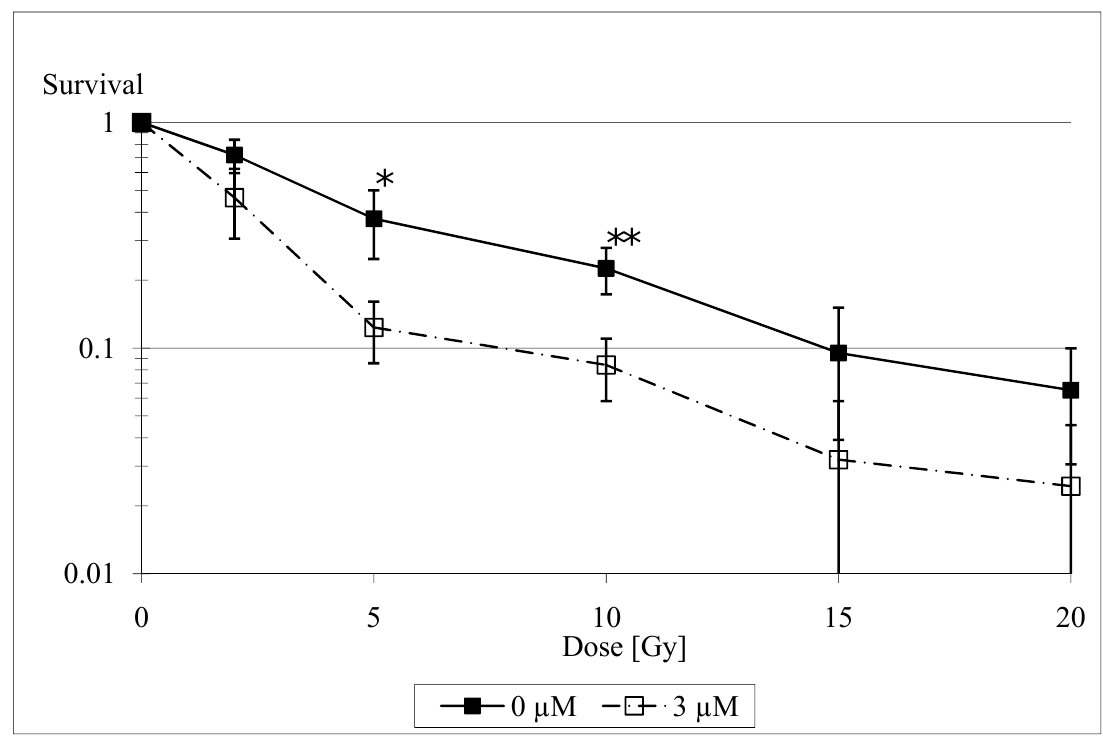
Figure 1. Logarithmic plot of cell survival at doses between 0 Gy and 20 Gy for selenite concentrations of 0 µM and 3 µM. Bars denote 95% confidence intervals. Asterisks denote significant values (* p < 0.05; ** p <